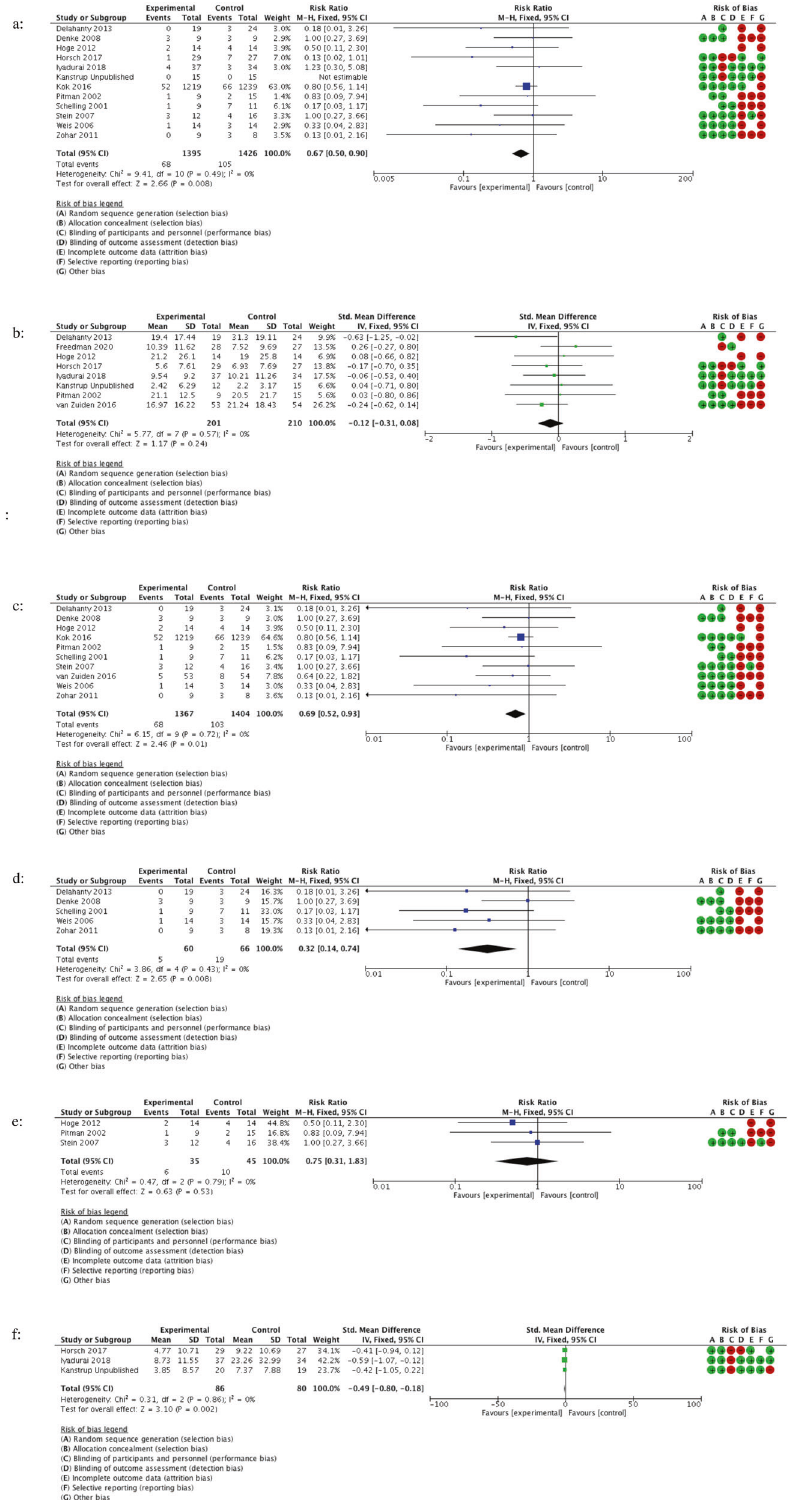
Fig. 3 Forest plots of effects of consolidation therapies for PTSD/re-experiencing/intrusive memory prevention in adult participant RCTs. a All pharmacological/psychological consolidation interventions assessing PTSD incidence at 1 – 48 months. b All pharmacological/ psychological consolidation interventions assessing PTSD severity at 2 weeks – 6 months. c All pharmacological consolidation interventions assessing PTSD incidence at 3 – 48 months. d Hydrocortisone interventions assessing PTSD incidence at 3 – 31 months. e Propranolol interventions assessing PTSD incidence at 3 – 6 months. f Cognitive task memory interference procedure with MR interventions assessing intrusive memory severity at 1